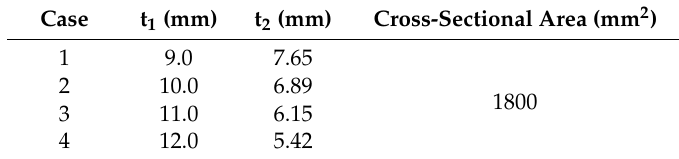
Table 2. Case studies of the t 1 and t 2 values of the tunnel-type bus-bar satisfying area of 1800 mm 2 .